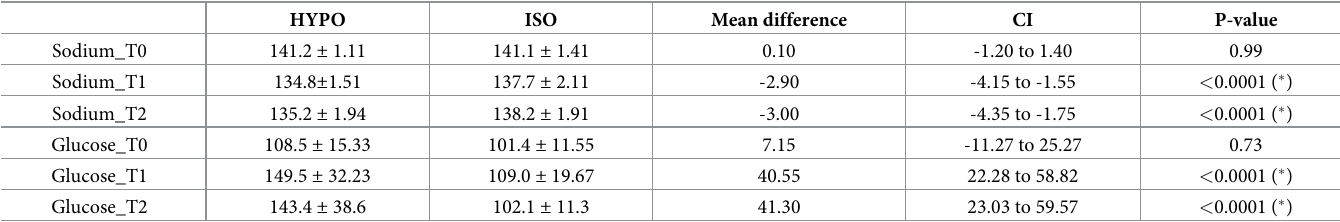
Table 3. Mean and SD of plasma sodium and glucose level at T0, T1, and T2. HYPO ISO Mean difference CI P-value Sodium_T0 141.2 ± 1.11 0.99 Sodium_T1 134.8 ± 1.51 Sodium_T2 135.2 ± 1.94 Glucose_T0 108.5 ± 15.33 -11.27 to 25.27 0.73 Glucose_T1 149.5 ± 32.23 109.0 ± 19.67 40.55 22.28 to 58.82 Glucose_T2 143.4 ±